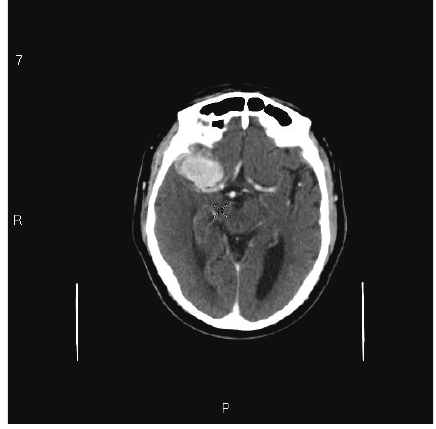
Figure 2: Contrast CT scan showing a 4cm enhancing mass in the right middle cranial fossa in keeping with a sphenoidal ridge